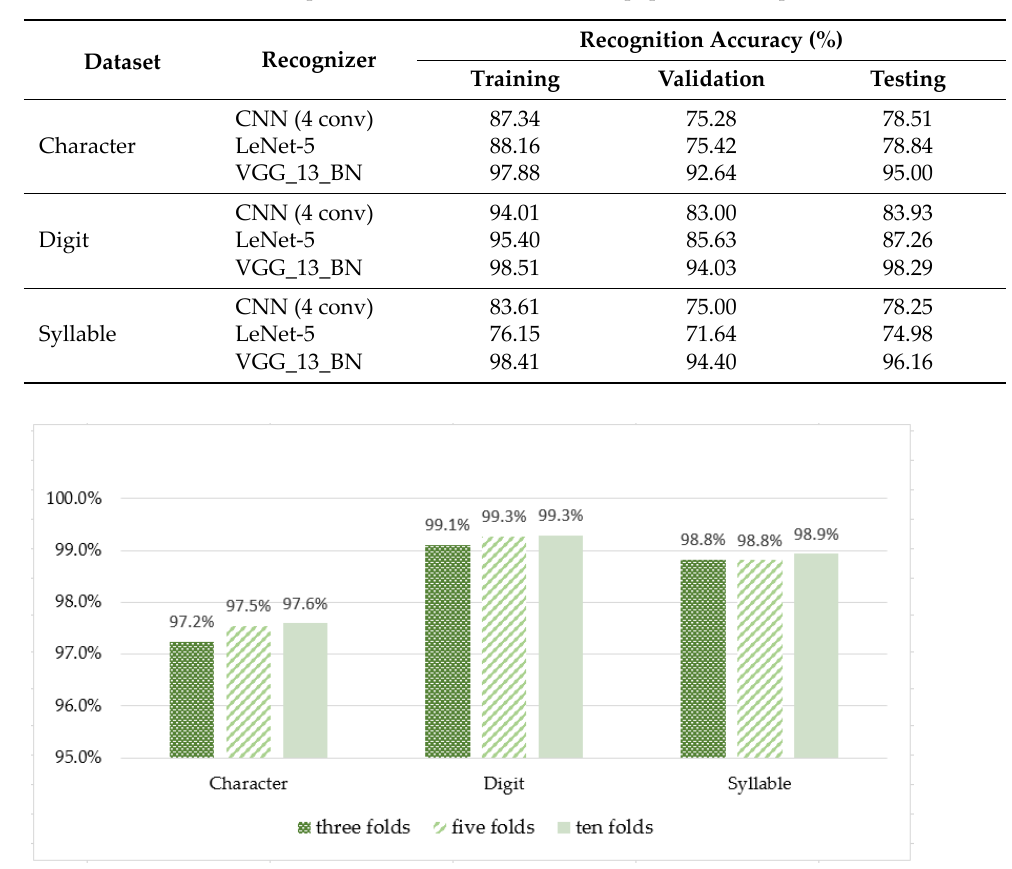
Figure 8. Result of BURAPHA-TH dataset ranking K-fold cross-validation.